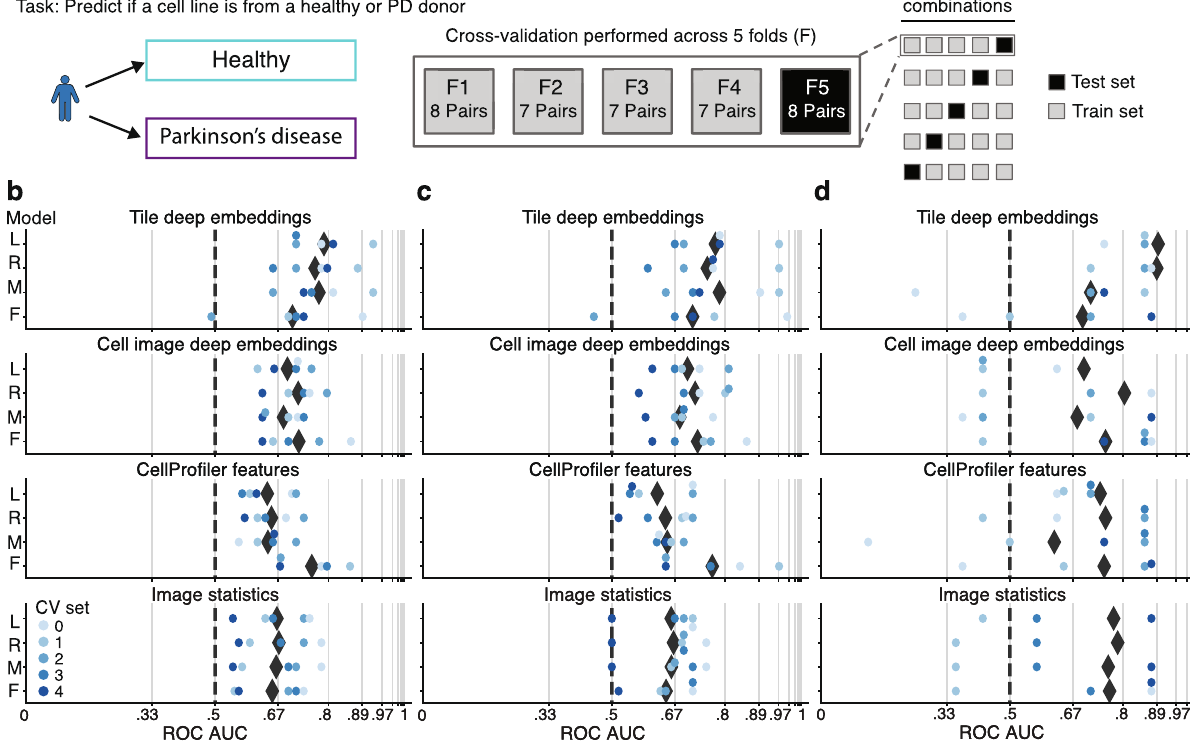
Fig. 5 PD-speci fi c signatures identi fi ed in sporadic and LRRK2 PD primary fi broblasts. a PD vs. healthy classi fi cation task uses a k-fold cross-validation strategy with held-out PD-control cell line pairs. Cell line – level ROC AUC, the probability of correctly ranking a random healthy control and PD cell line evaluated on held out – test cell lines for b LRRK2 /sporadic PD and controls c sporadic PD and controls and d LRRK2 PD and controls, for a variety of data sources and models (logistic regression (L), ridge regression (R), multilayer perceptron (M), and random forest (F)), range from 0.79 – 0.89 ROC AUC for the top tile deep embedding model and 0.75 – 0.77 ROC AUC for the top CellPro fi ler feature model. Black diamonds denote the mean across all cross- validation (CV) sets. Grid line spacing denotes a doubling of the odds of correctly ranking a random control and PD cell line and dashed lines denote chance sources for model fi tting in PD vs. healthy classi fi cation. The